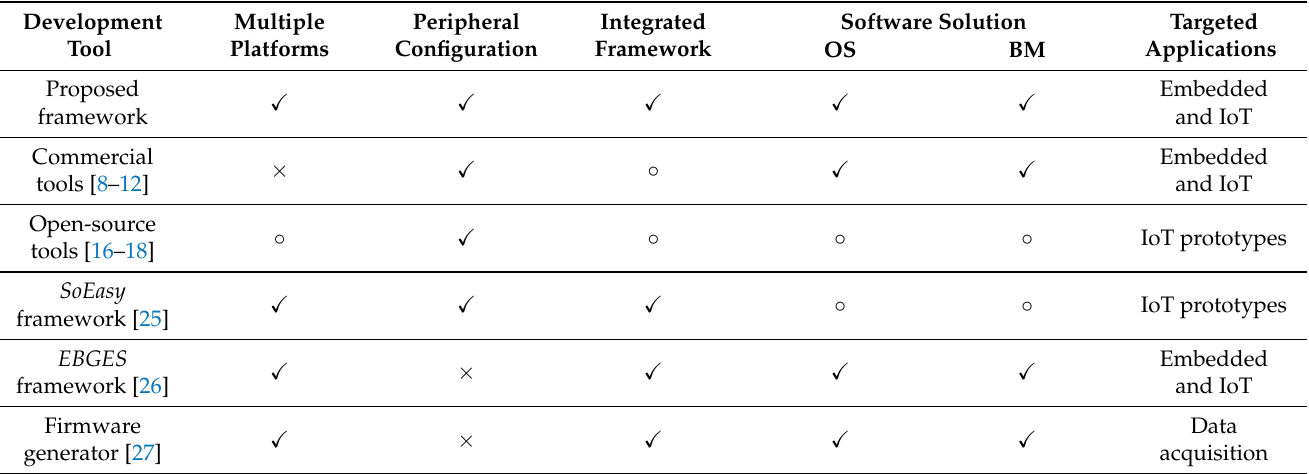
Table 1. Comparative analysis of features for the different evaluated software development tools (Fully supported: (cid:88) , Limited support: ◦ , Not supported: ×